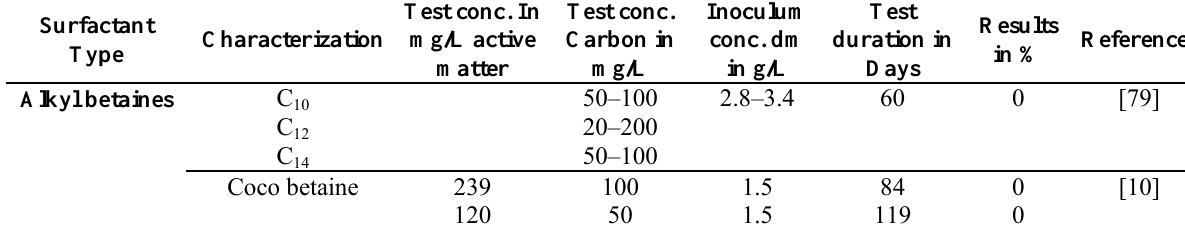
Table 8. Anaerobic biodegradability of amphoterics in screening tests (according ECETOC).